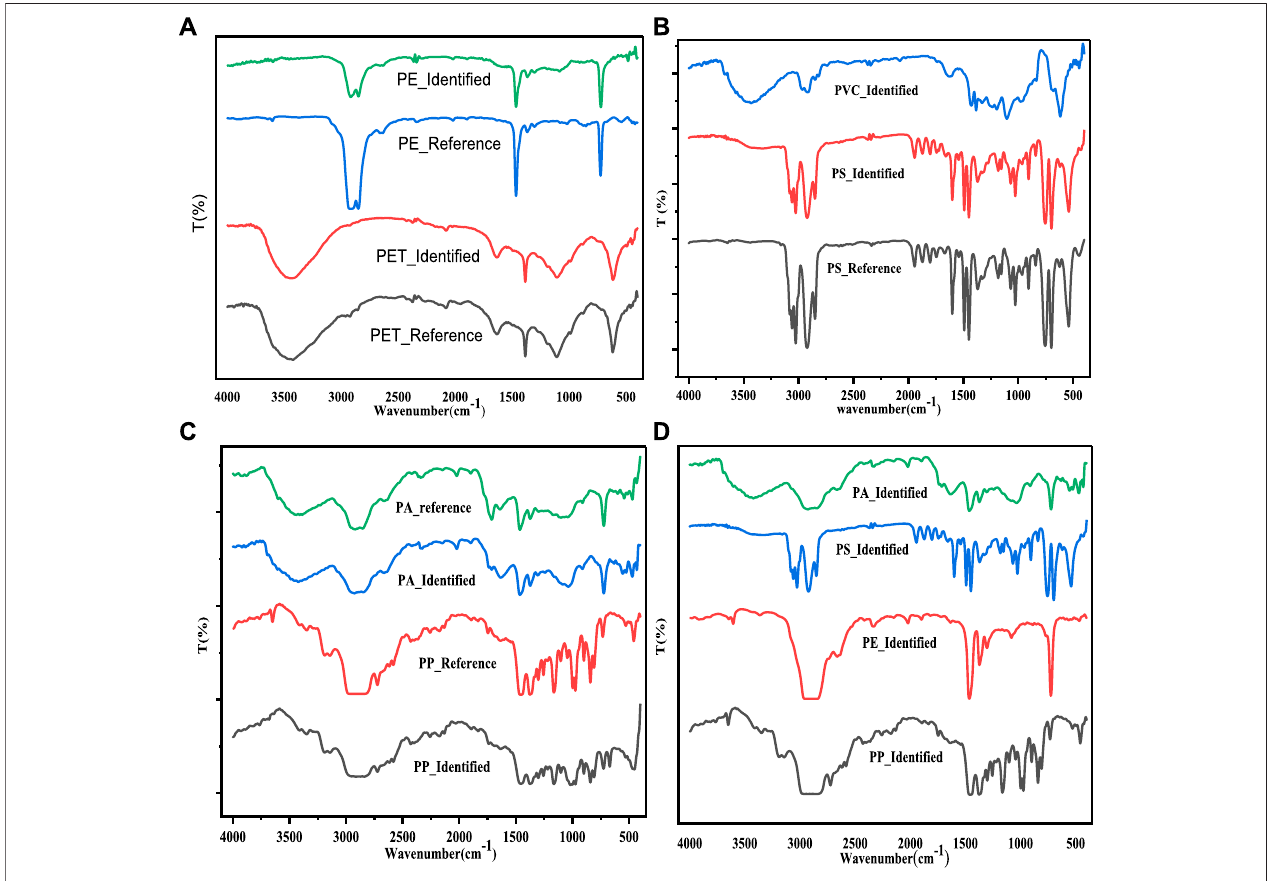
FIGURE 7 | Fourier transform infrared (FTIR) spectroscopic polymer type identi fi cation of MPs in sediment samples (A – C) and water samples (D) .